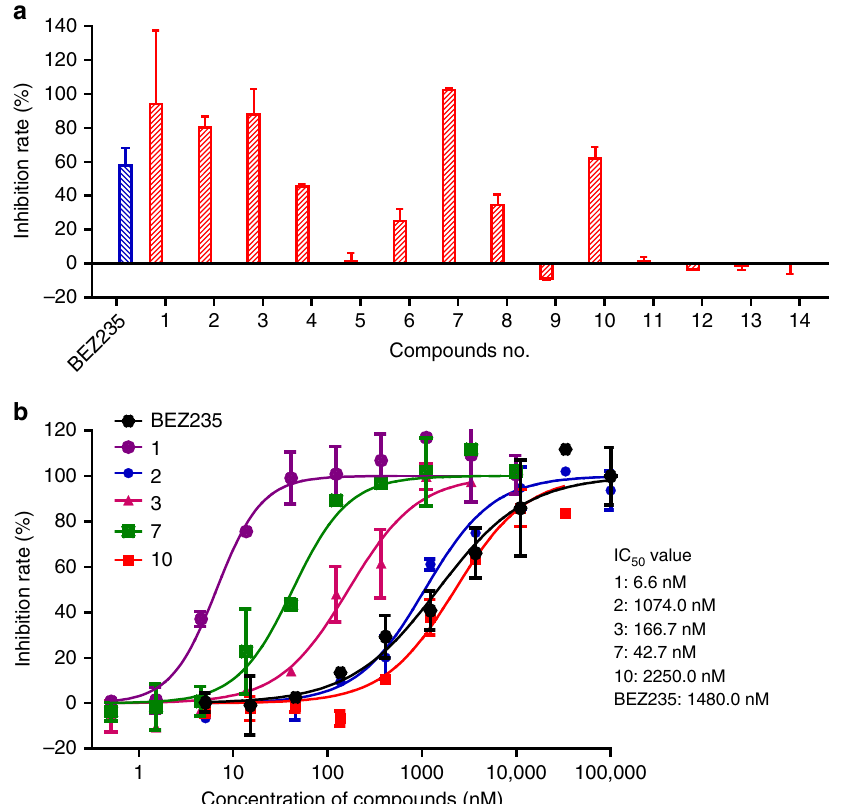
Fig. 8 Phosphatidylinositol 3-kinase (PI3K) inhibitory activity. a The inhibitory effects of compounds 1 – 14 against PI3K, with BEZ235 as the positive control. The inhibition ratio of a certain sample on PI3K was calculated according to the following formula: PI3K inhibition (%) = (ER sample – ER 0% )/(ER 100% − ER 0% ) × 100%, as described in method section. Data represent mean ± SD of two replicates. b The IC 50 values of compounds 1 – 3 , 7 , 10 , and BEZ235. The IC 50 values were estimated using the “ Sigmoidal dose-response (variable slope) ” equation in the GraphPad Prism ® Version 5.0 software. Data represent mean ± SD of two